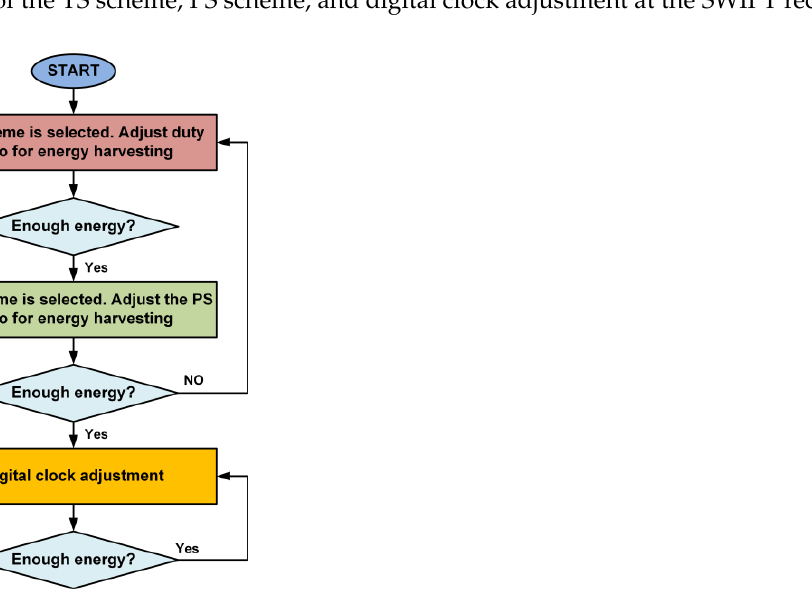
Figure 6. Flow diagram for the selection of the TS scheme, PS scheme and digital clock adjustment at the SWIPT receiver.